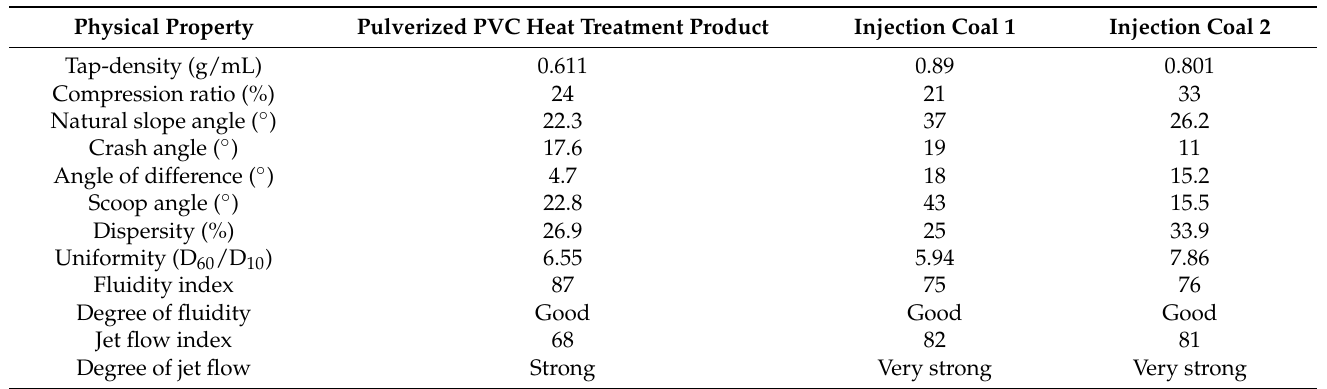
Table 3. Powdery properties of pulverized PVC370 and injection coal.